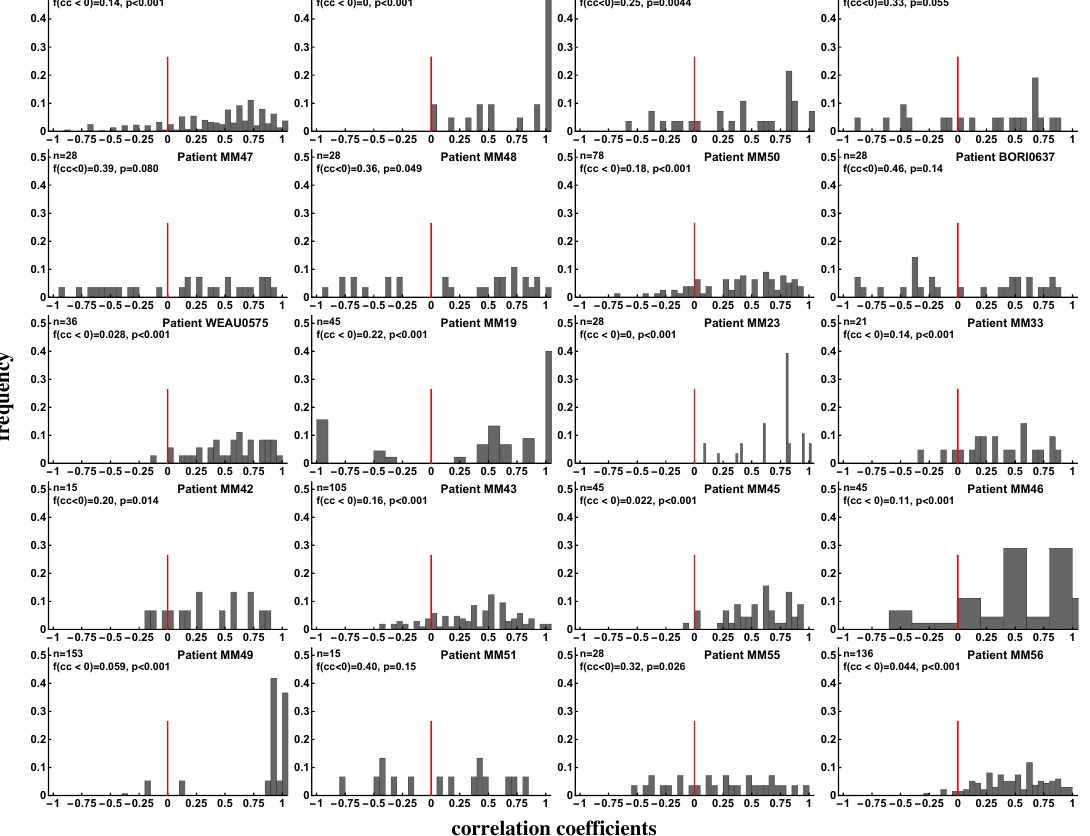
Figure 8. Evidence of interclonal competition between epitope-specific CD8 + T cell responses. We calculated Spearman’s rank correlation coefficients between longitudinal changes of pairs of epitope-specific CD8 + T cell responses in a given patient (see individual panels) and plotted the distribution of these coefficients. Panels show the number of correlations ( n ), fraction of negative correlation coefficients ( f ( cc ) < 0), and p values for the deviance of the distribution from uniform, found using the binomial test with null being the equal fraction of positive and negative correlations. We found that the majority of CD8 + T-cell populations expand and contract in unison and therefore do not appear to compete during the infection. Overall, discordant dynamics (negative correlation coefficients) were observed for 18% of all responses irrespective of the stage of infection (acute or chronic). Patients MM38 and MM40 were excluded from the analysis for having too few correlation pairs (two or